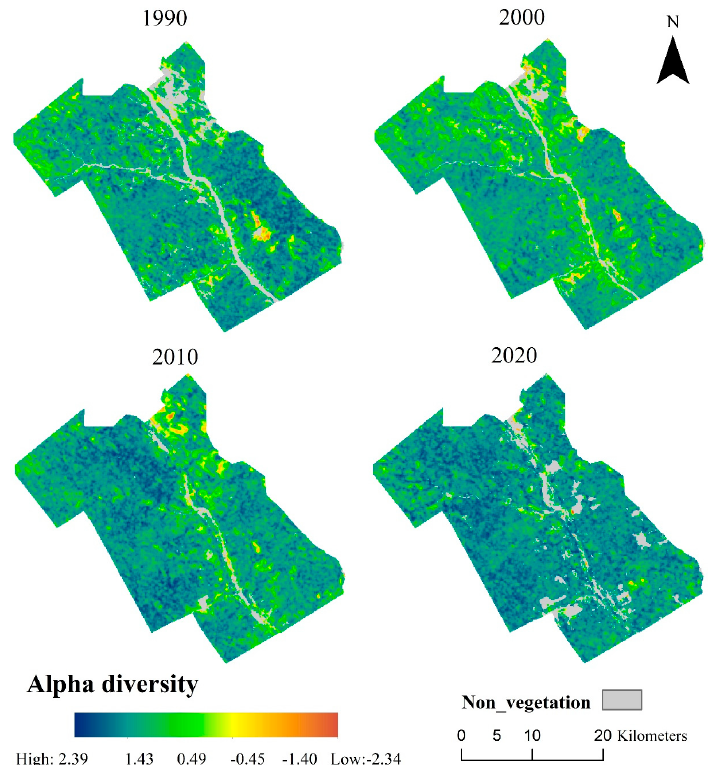
Figure 5. Alpha diversity of the study area in 1990, 2000, 2010, and 2020.